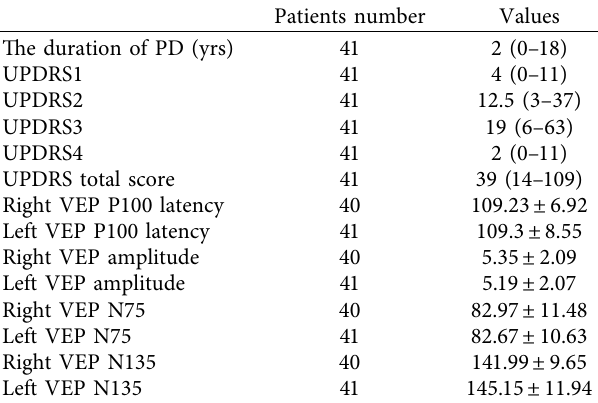
Table 4: VEP variables and UPDRS scores of the PD group. Patients number